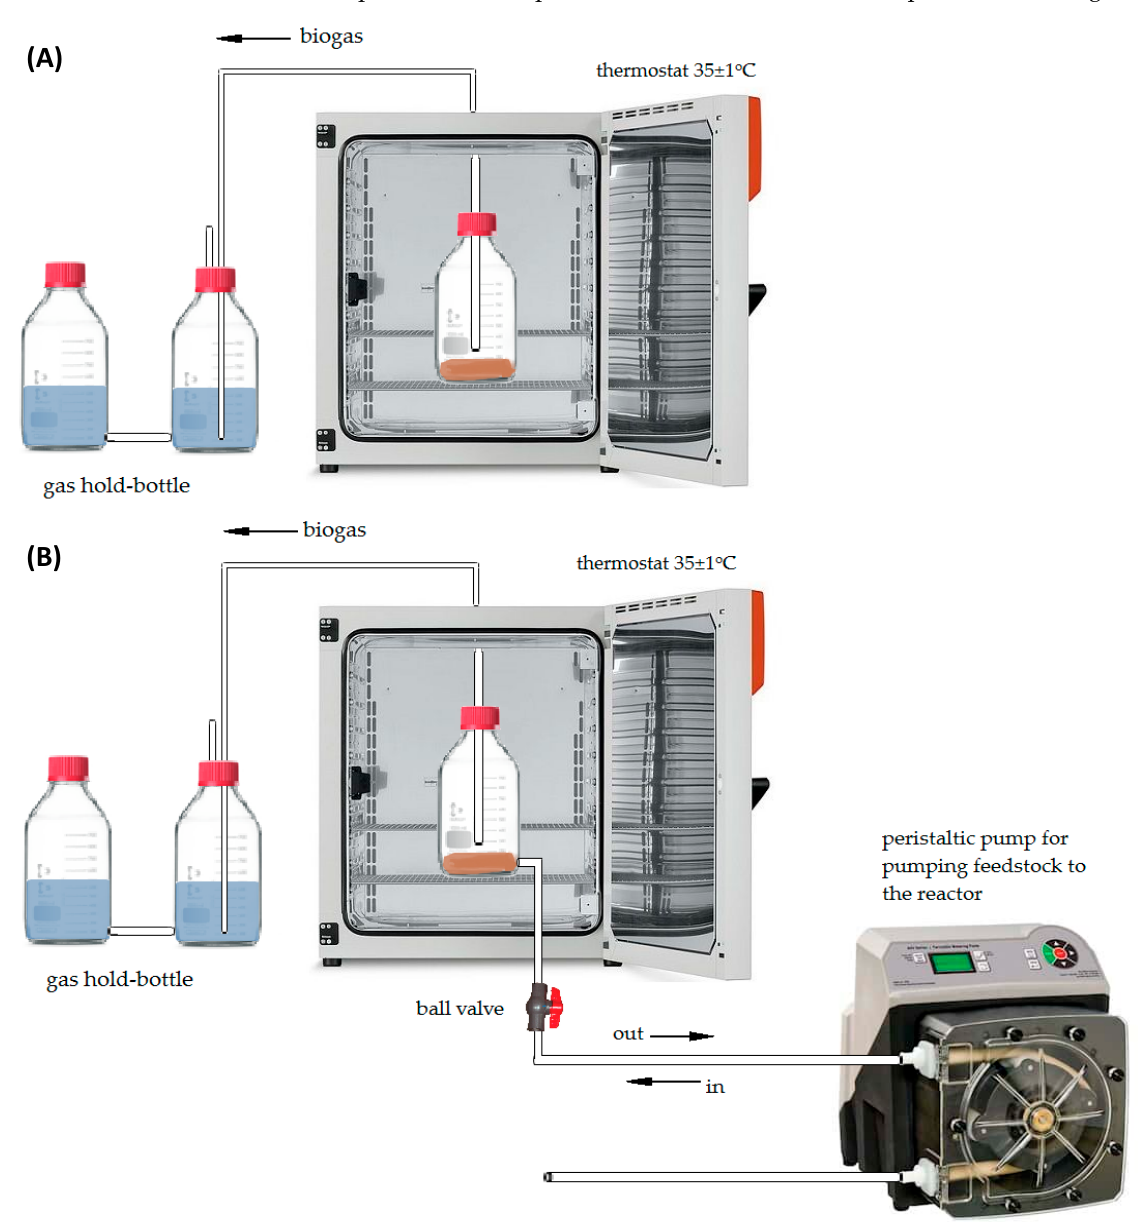
Figure 8. Laboratory installation for batch ( A ) and semicontinuous ( B ) experiments. Semicontinuous experiments (R-1 and R-2) were carried out in two identical cylindrical digesters each with total and working volumes of 3 L and 5 L, respectively (Figure 8B). They were placed in a thermostat to provide a stable temperature of 55 ◦ C. The headspace of the digester was connected to a set of two bottles, each with a working volume of 4 L, to measure biogas production by a water displacement method. The digesters were fed once a day using a peristaltic pump. For this purpose, a certain volume of the digestate was collected, and the same amount of the feed was introduced to the reactor afterward, which provided a desired SRT. The digestates from batch tests were used as the inoculum for semicontinuous trials; hence, no special acclimation of the digesters was required. The digesters were fed with a mixture of acid splitting wastewater, interphase, and MONG in the proportion that reflected the real amounts of these materials generated by the KLM plant. Details of the digester performances are summarized in Table 3.